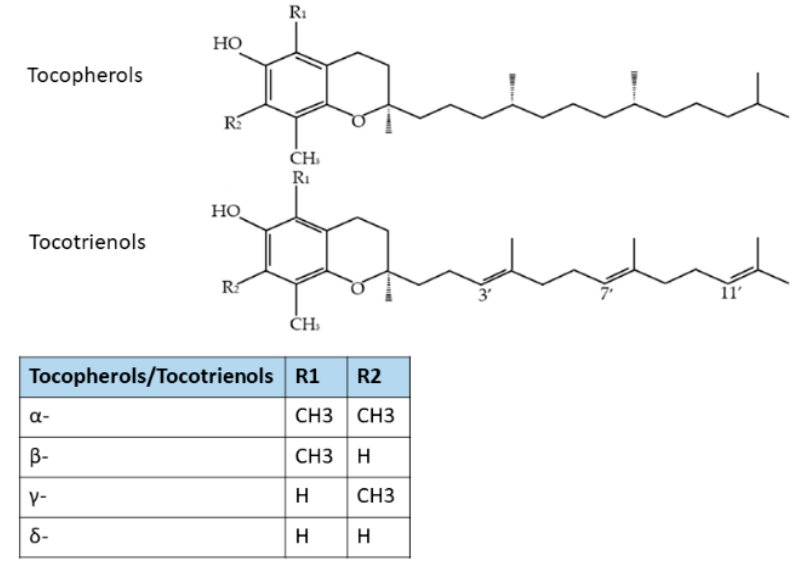
Figure 3. Molecular structures of Tocopherols and Tocotrienols. Modified from [163].